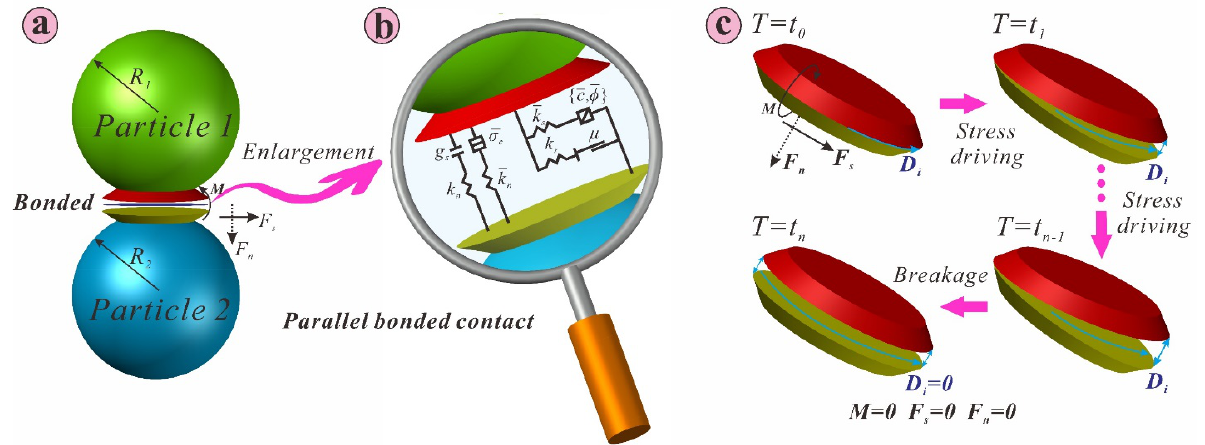
Figure 7. Schematic diagrams of the whole process of the parallel bond diameter attenuation mech- anism: ( a ) Description of the parallel bond contact between two particles. F n , F s and M represent the normal force, shear force and bending moment, respectively; ( b ) Enlarged details of the parallel bond contact, k n , k s , µ denote the normal stiffness, shear stiffness and friction coefficient, respectively. g s is surface gap, which defined as the difference between the contact gap and the reference gap; ( c ) Attenuation model of the parallel bond diameter over time. t i , i = 0,…, n − 1, n indicates the various moment of deterioration.